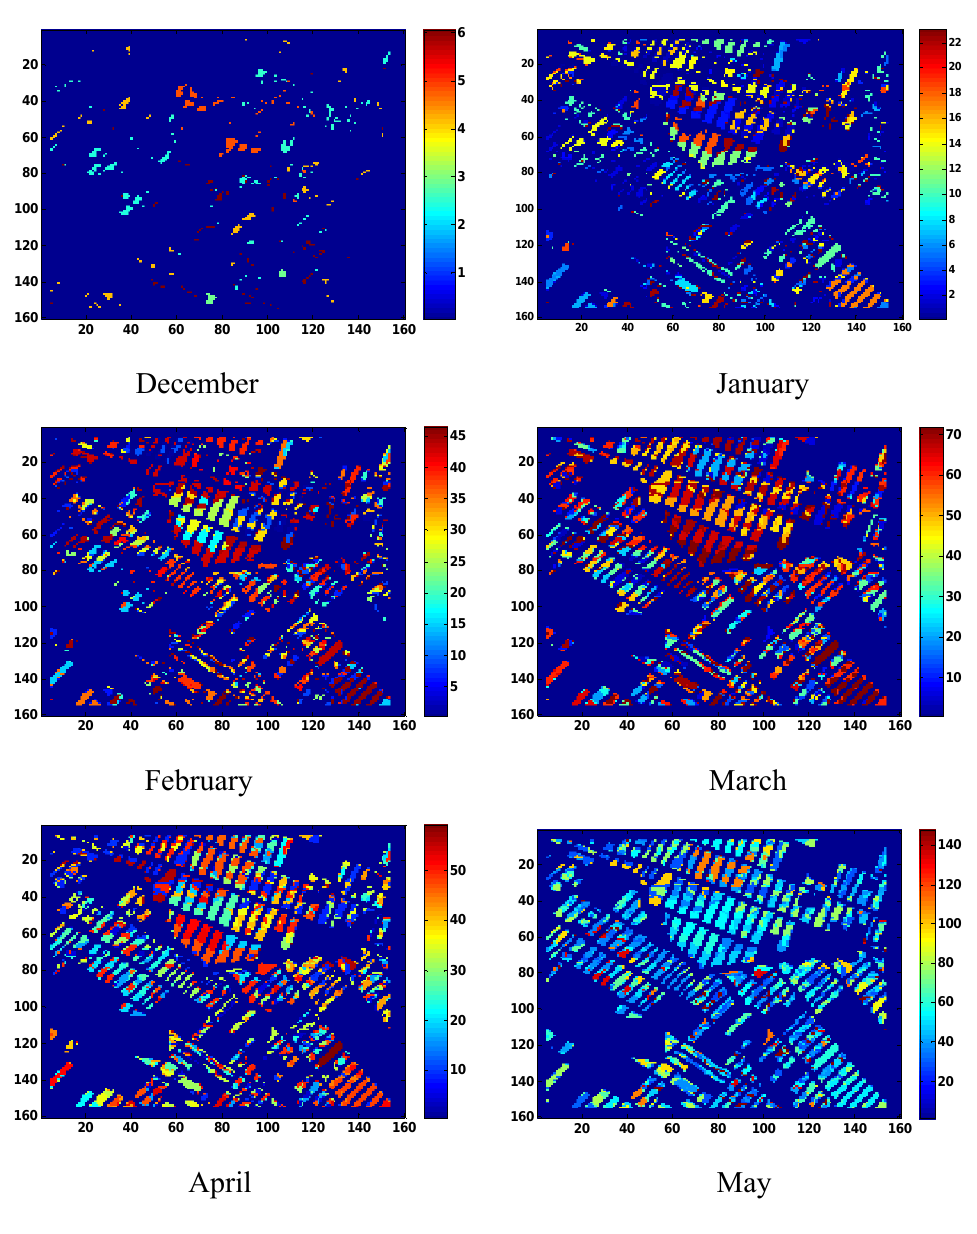
Figure 7. Spatial and temporal distribution of irrigation amount (mm) of winter wheat in the Tensift ALHaouz basin during 2002–2003 growing